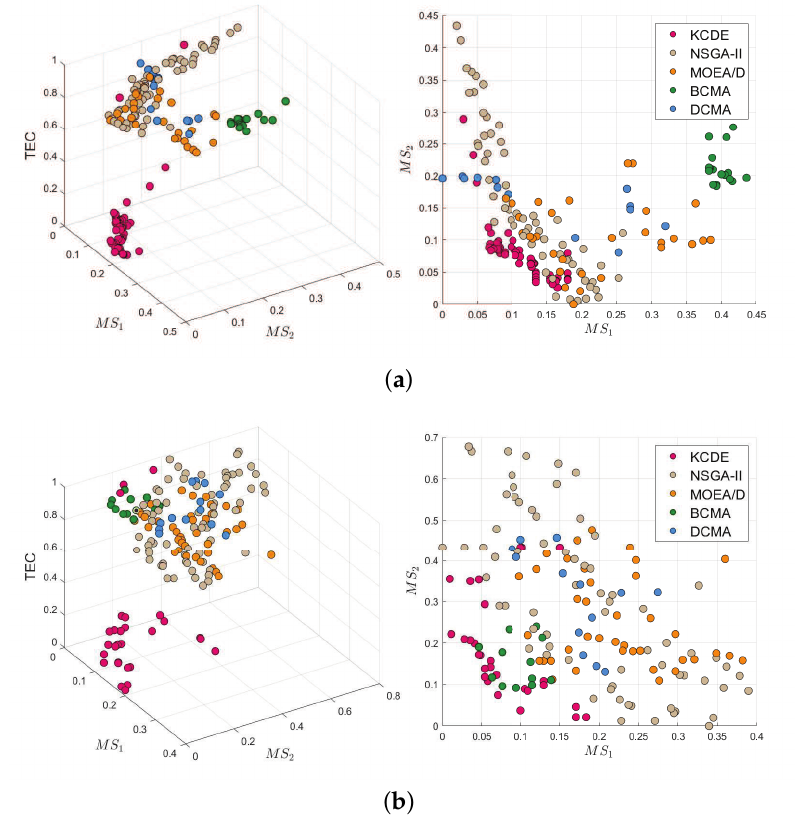
Figure 8. Distribution of non-dominated solutions obtained by KCDE, NSGA-II, MOEA/D, BCMA and DCMA; ( a ) Non-dominated solutions on instance f3n30+30s5; ( b ) Non-dominated solutions on instance